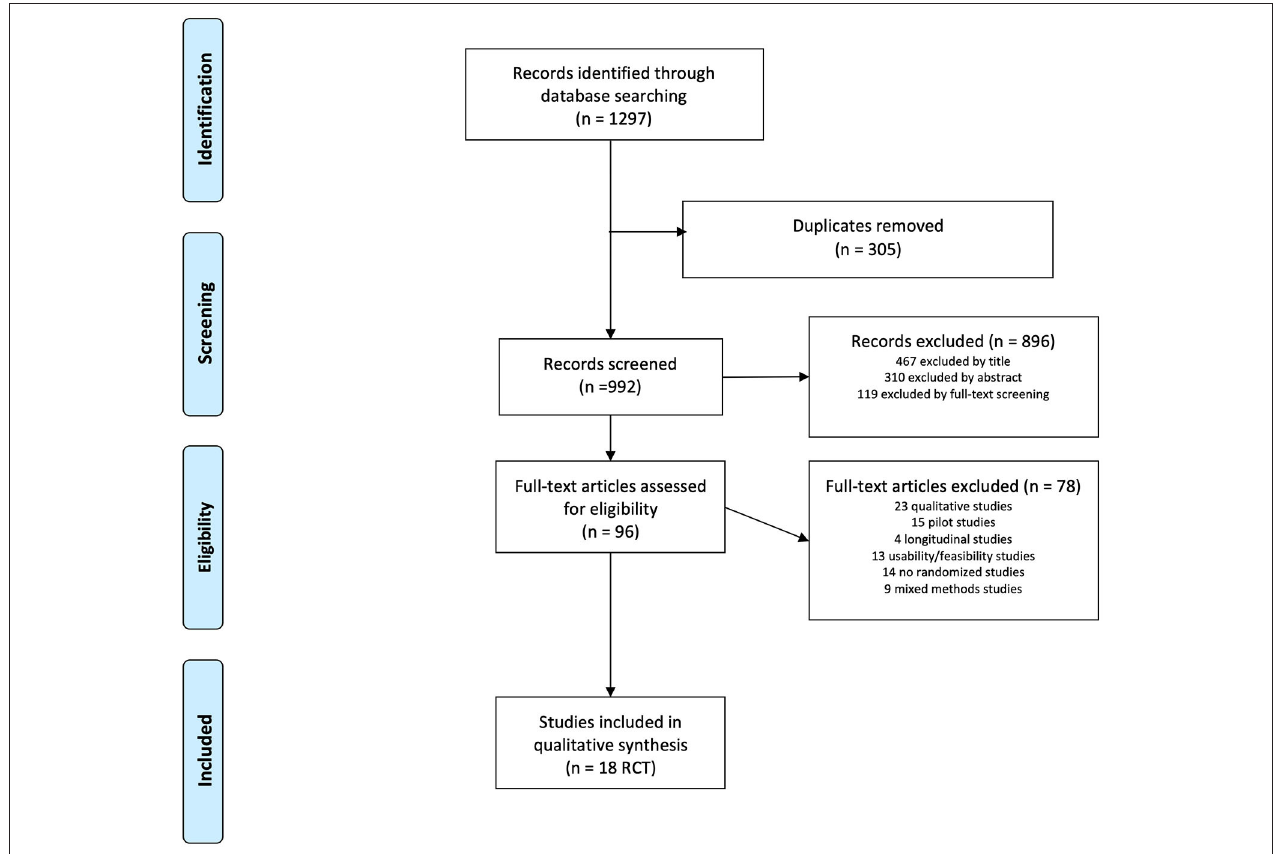
FIGURE 1 | Selection study. Prisma 2009 flow